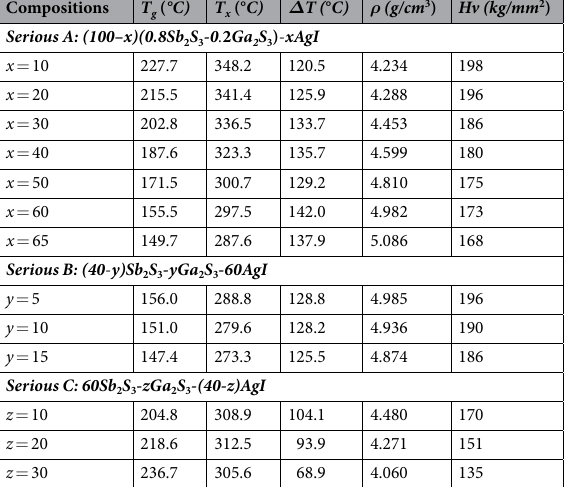
Table 1. Thermal and Physical properties of Ga2S3-Sb2S3-AgI Glasses.